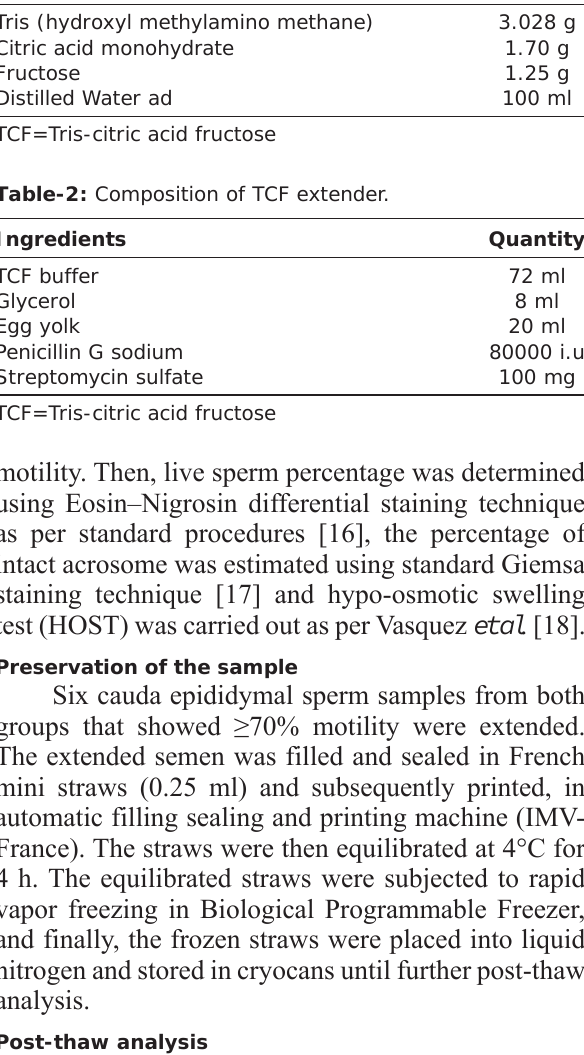
Table-1: Composition of TCF buffer. Ingredients